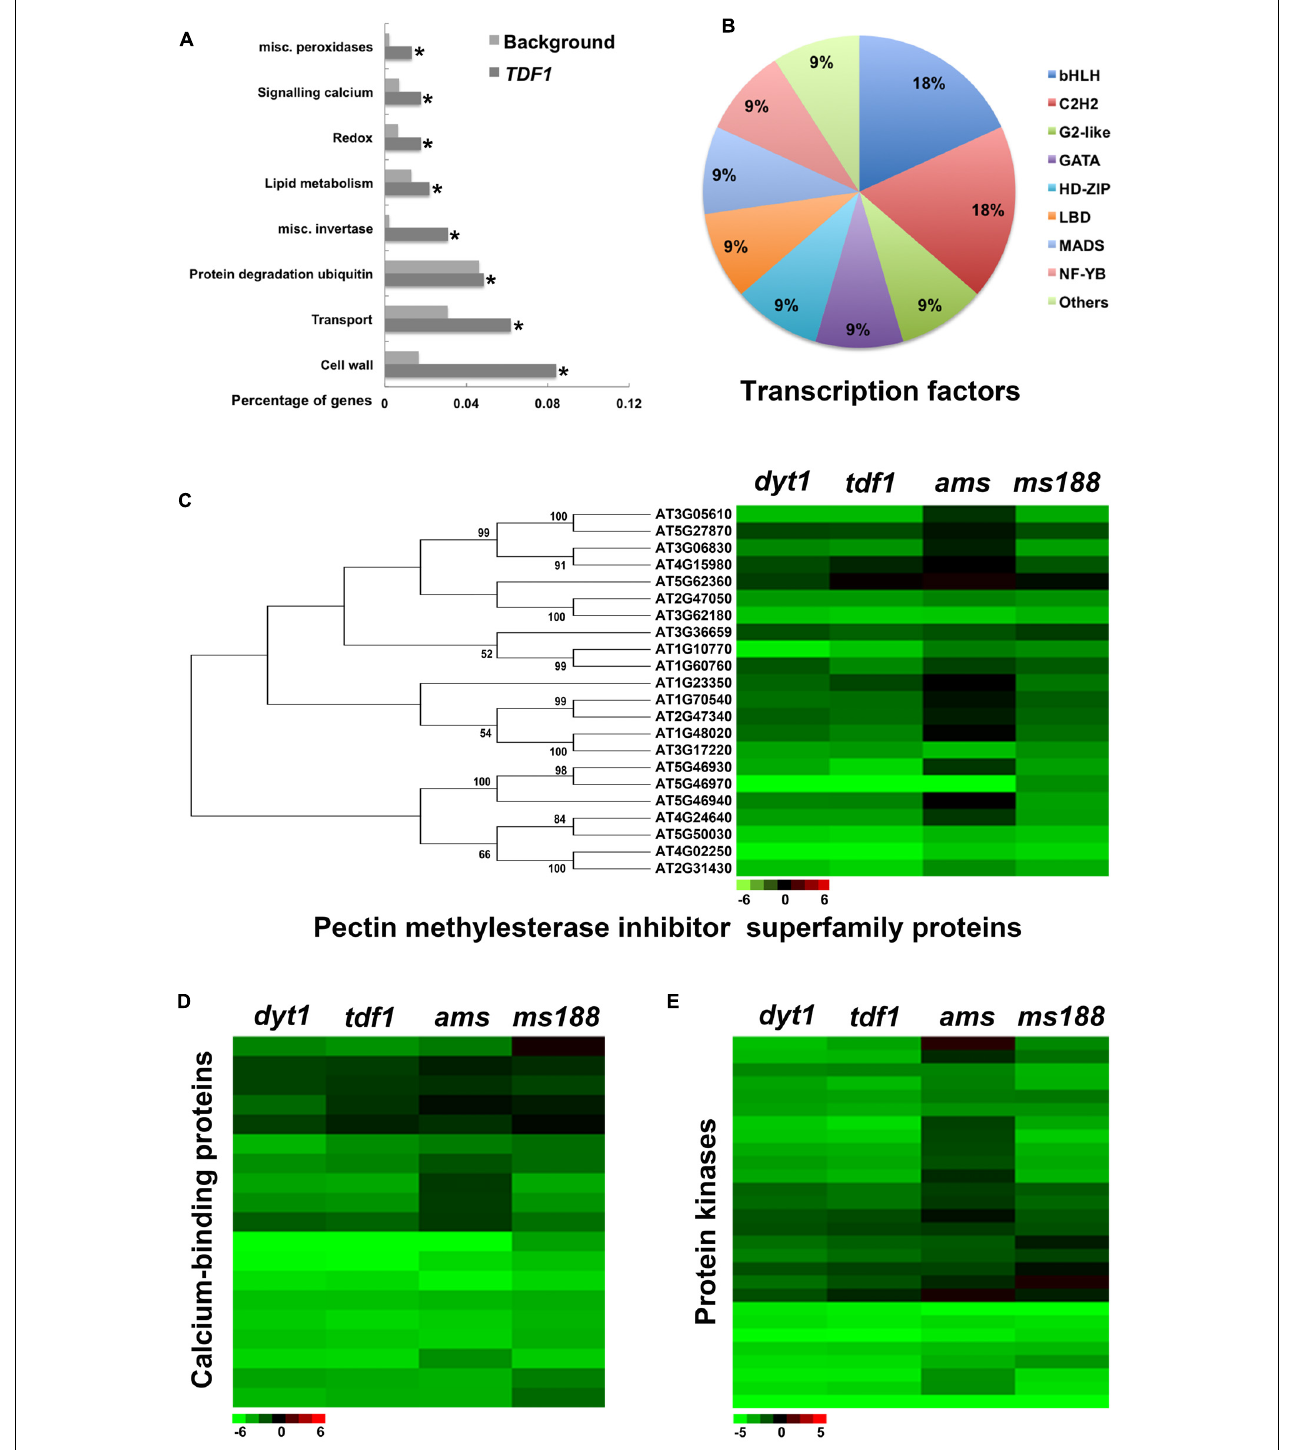
FIGURE 4 | Functional analysis of TDF1 -specific genes. (A) GO enrichment analysis of TDF1 -specific genes. (B) Subsets of transcription factors in TDF1 -specific genes. (C) Cluster and heat map of mRNA expression profiles of pectin methylesterase inhibitor superfamily proteins of TDF1 in dyt1 , tdf1 , ams , and ms188 mutants. (D) Heat map of mRNA expression profiles of calcium-binding proteins of TDF1 in dyt1 , tdf1 , ams , and ms188 mutants. Green and red colors represent lower and higher log 2 fold change of expression in mutants compared with the wild type. (E) Heat map of mRNA expression profiles of protein kinases of TDF1 in dyt1 , tdf1 , ams and ms188 mutants. Asterisk indicates P values < 0.05 compared with background.